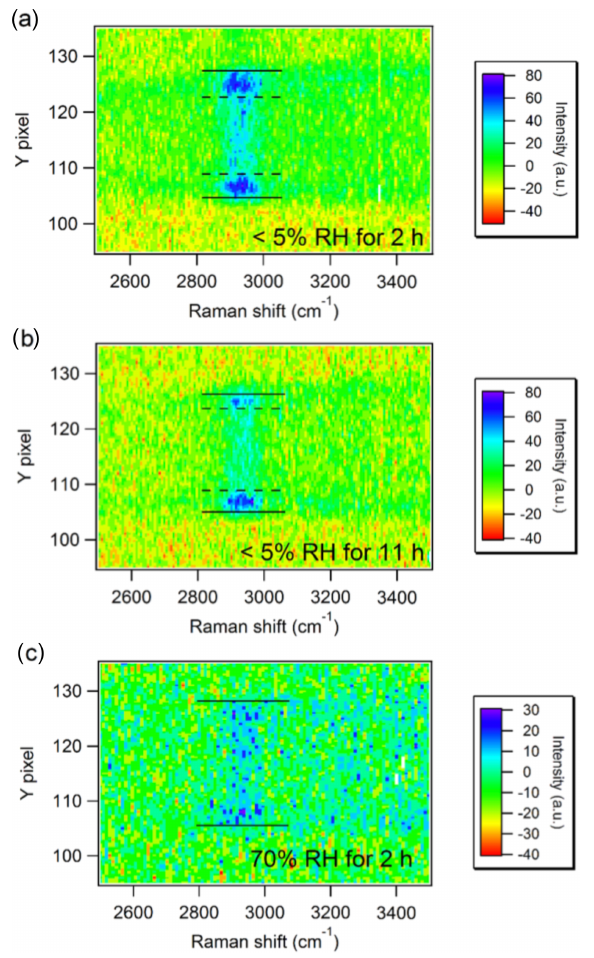
Figure 3. Spatially resolved Raman intensities of AS–sucrose (mo- lar fraction of sucrose in total solute ( F SU = 0 . 5)) particles equili- brated at < 5%RH for 2h (a) and for 11h (b) and at 70%RH for 2h (c) . C − H peaks at ∼ 2900cm − 1 represent sucrose. Solid lines indicate the particle’s upper and lower edges. The outer regions be- tween the dashed and solid lines are sucrose-rich in panels (a) – (b) (Chu and Chan,